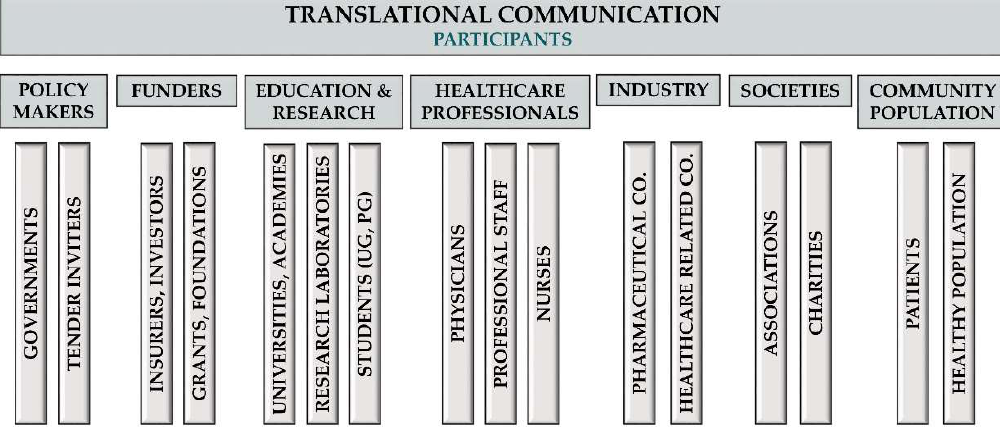
Figure 6. Participants of translational communication.